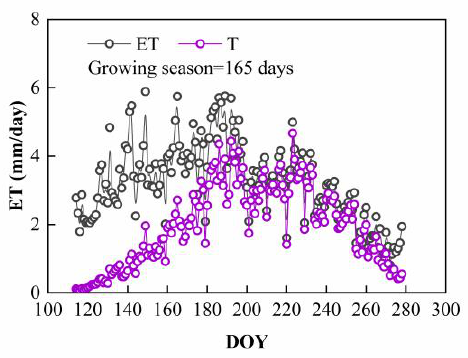
Figure 6. Variations in maize ET and T in Hangjinhouqi during the growing season of 2012.